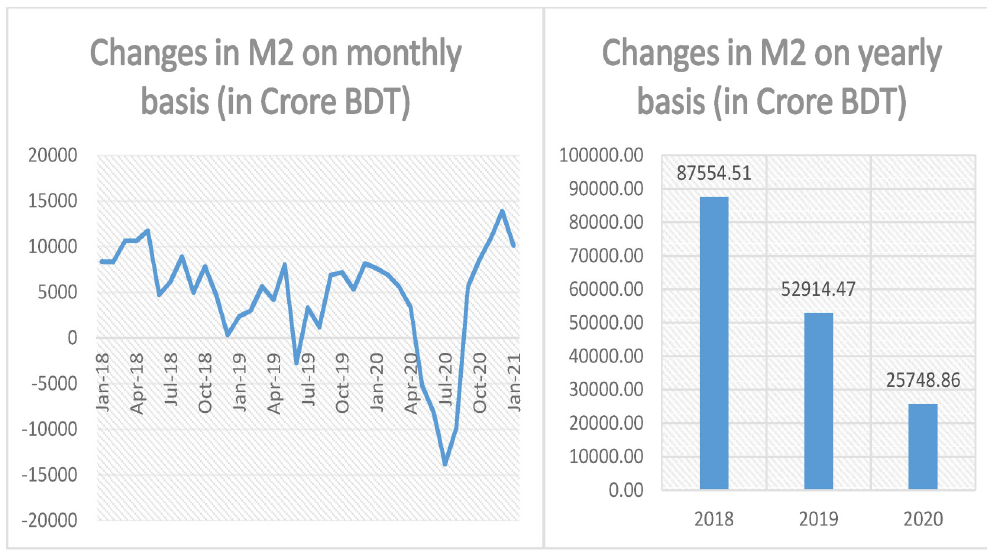
Fig 4. Monthly and yearly changes in broad money (M2) due to MFS